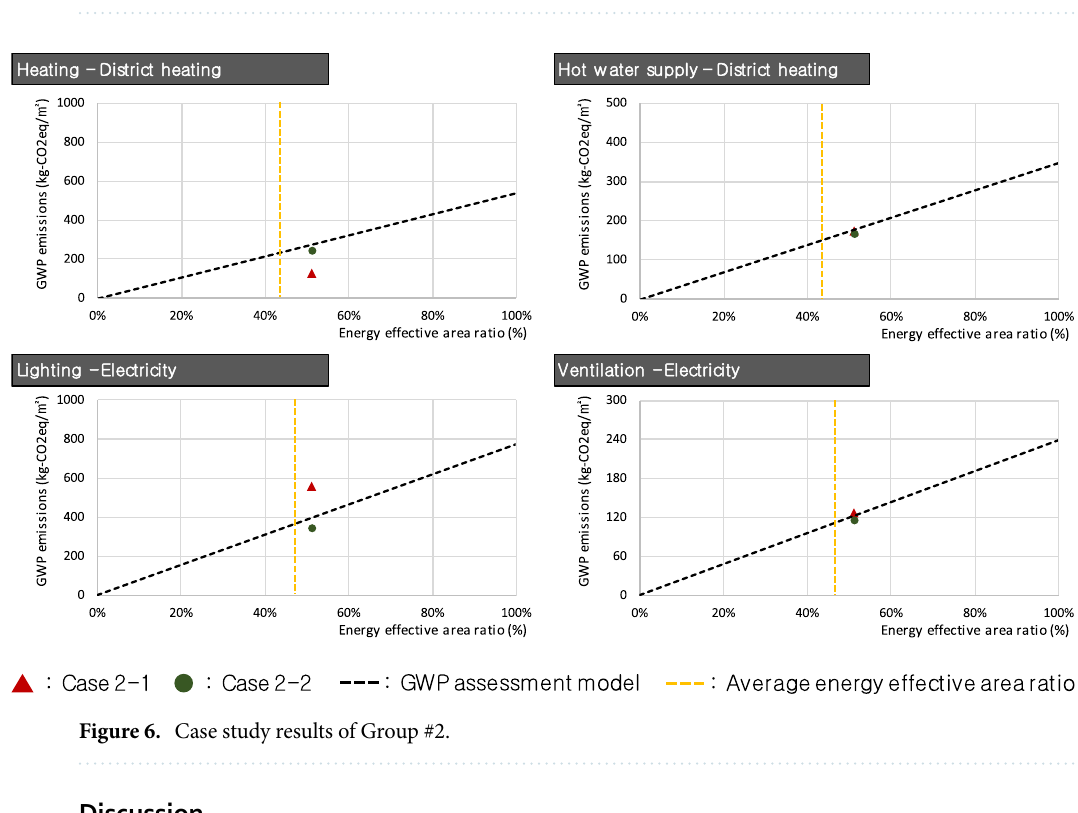
Figure 6. Case study results of Group